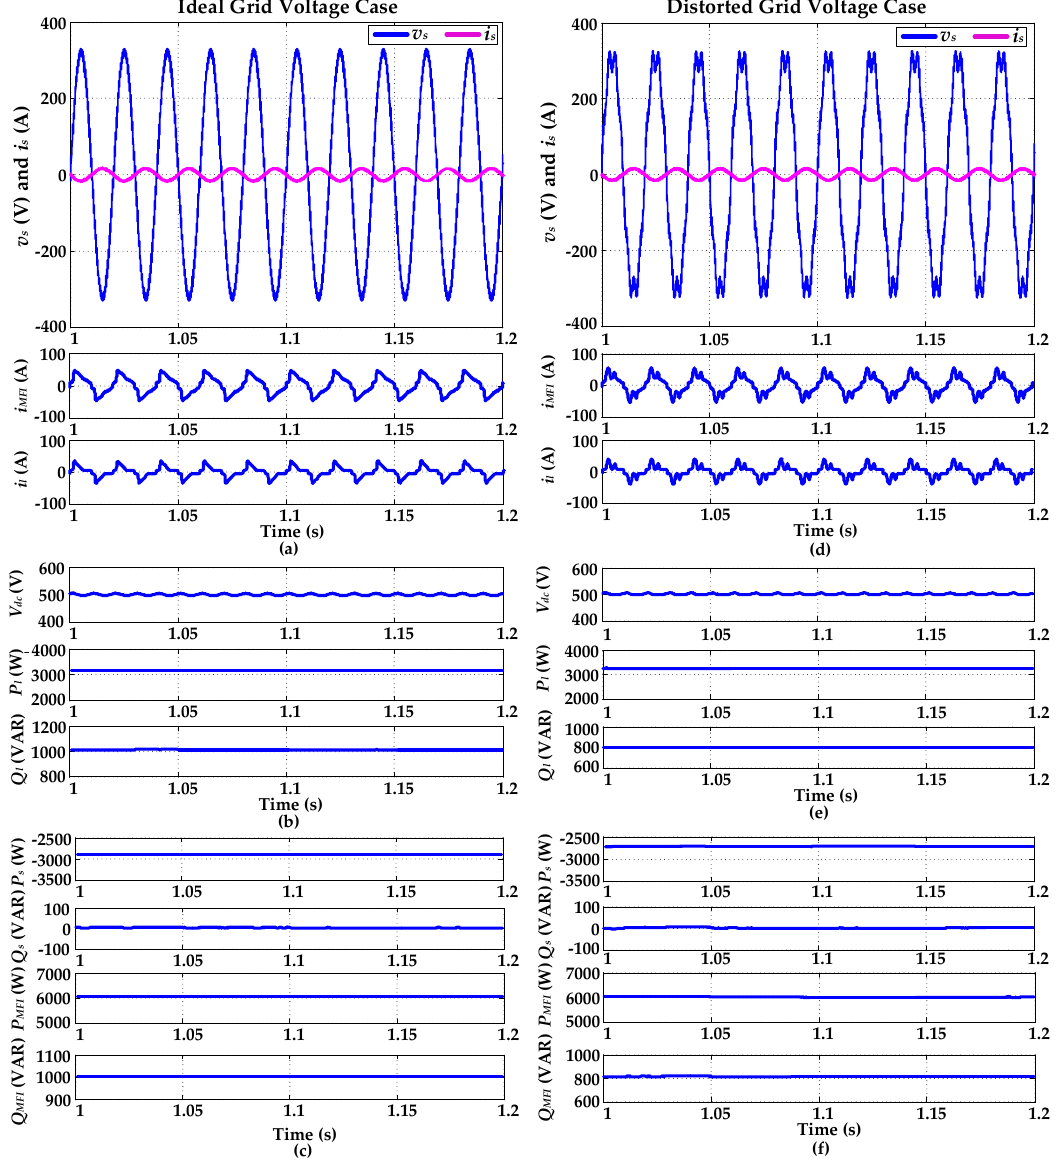
Figure 9. Simulated output waveforms under MFI ON with grid feeding and power conditioning mode; ( a ) ideal grid input voltage, current, MFI current, and load current; ( b ) MFI DC-link voltage, and load active and reactive power under ideal grid; ( c ) source active power, reactive power, and MFI active and reactive power under ideal grid; ( d ) distorted grid input voltage, current, MFI current, and load current; ( e ) MFI DC-link voltage, and load active and reactive power under distorted grid; ( f ) source active power, reactive power, and MFI active and reactive power under distorted grid .